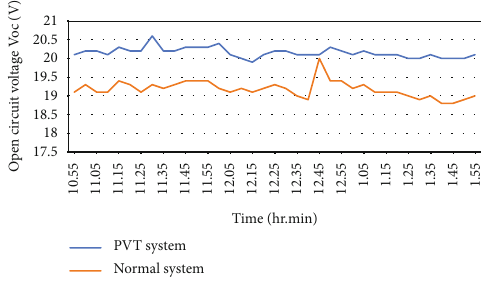
Figure 6: Open circuit voltage (Voc) of the PVT and the normal system. The average improvement in Voc is 0.97 V where the maximum improvement in Voc is 1.3V for the PVT system compared to the normal system.